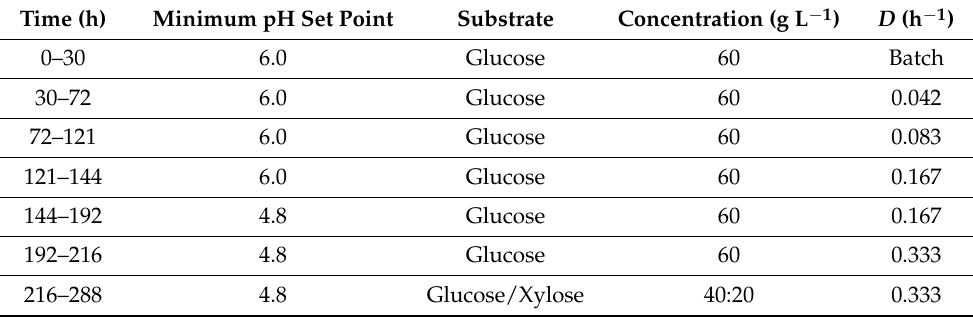
Table 2. Summary conditions of the continuous